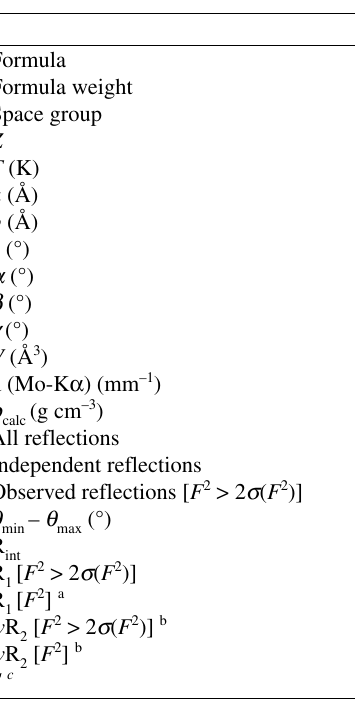
Table 1 . Crystallographic data for 1 , 2 and 3